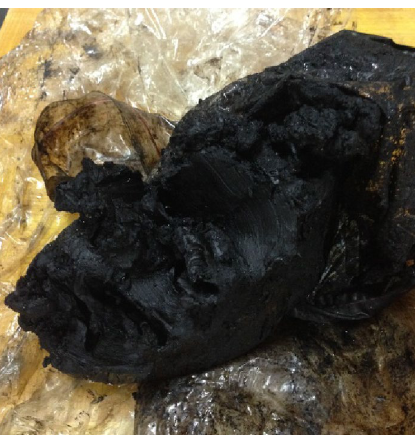
Fig. 2 Oil sample from Field X